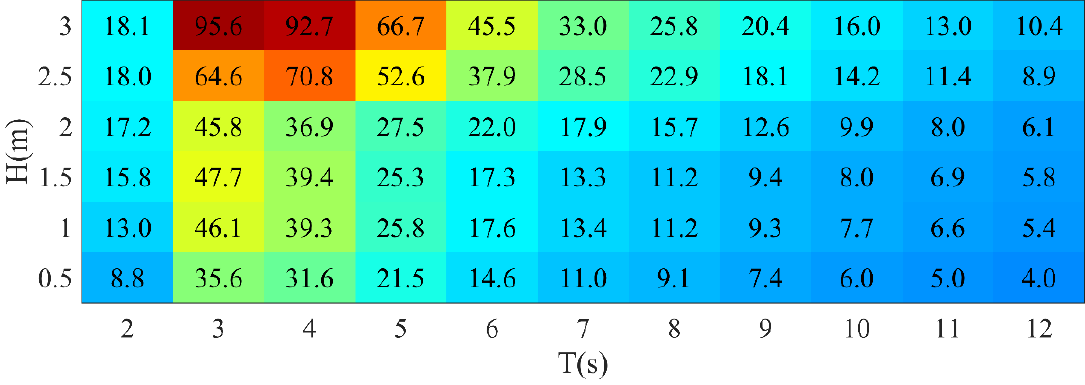
Figure 9. S-PWEC power generation efficiency under regular wave sea conditions.